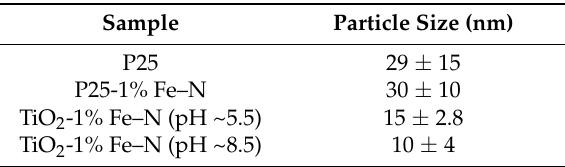
Table 3. The particle average size of the P25 and hydrothermally-synthesized samples. The results are expressed as mean ± standard deviation.